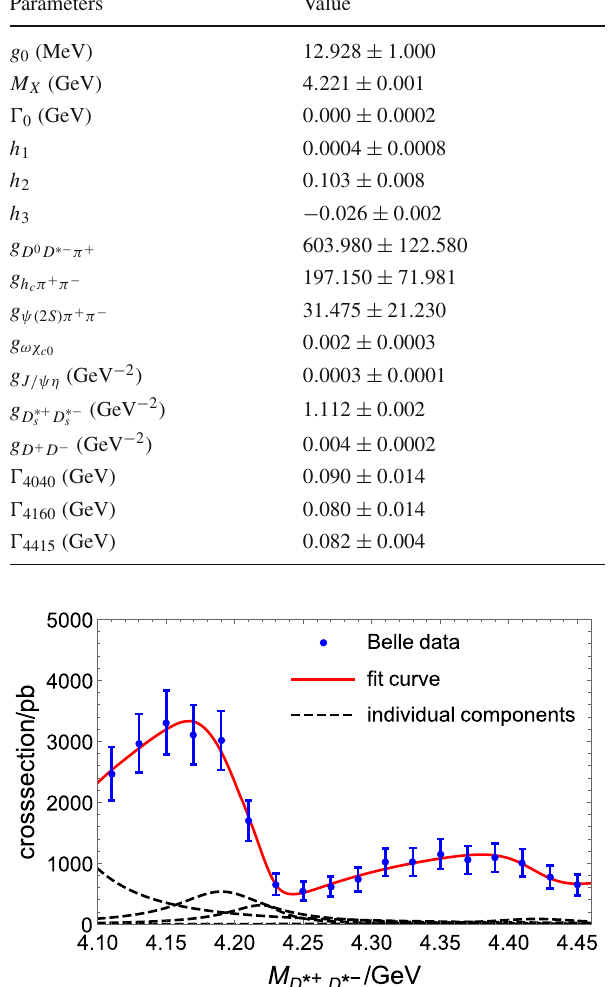
Table 2 Summary of relevant parameters without the D ∗+ s D ∗− s data Parameters